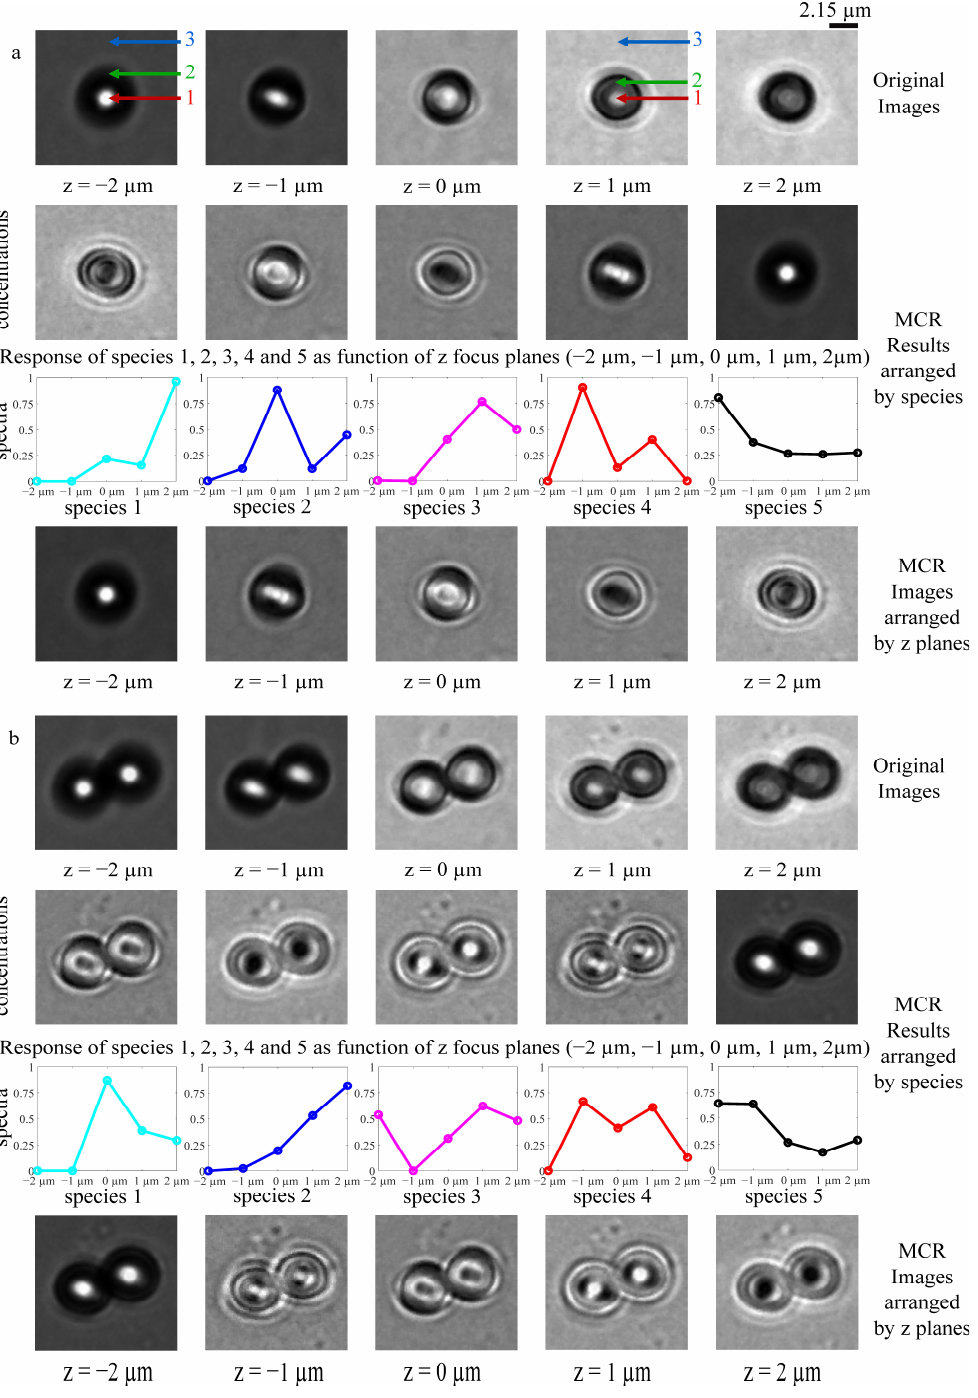
Figure 2. Pre-processed brightfield microscope images and results from MCR analysis for a single silica microbead ( a ) and a pair of silica microbeads ( b